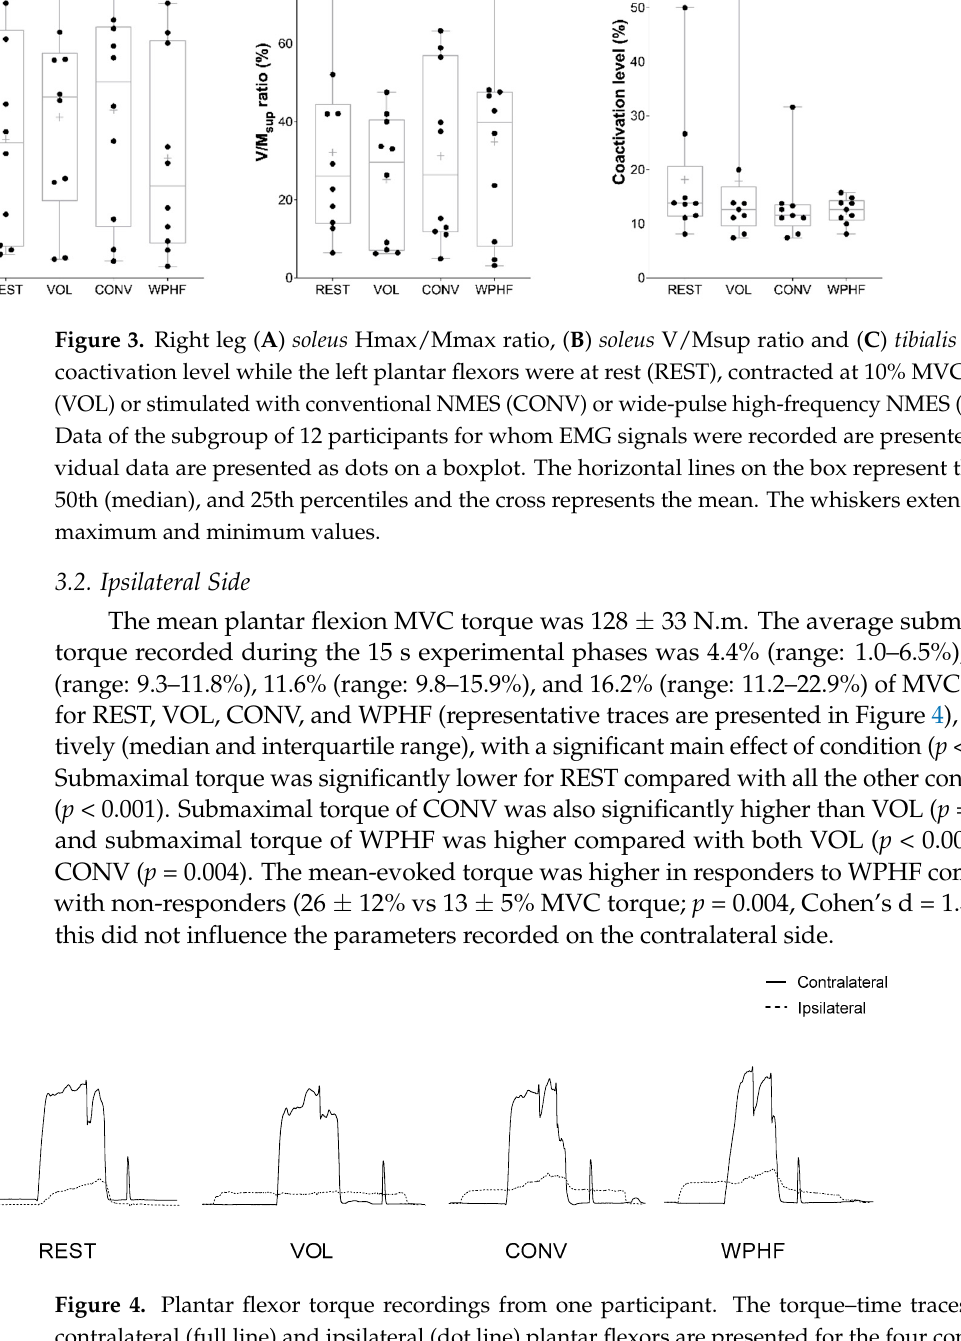
investigated: REST: Rest; VOL: voluntary contraction at 10% MVC torque; CONV: conventional